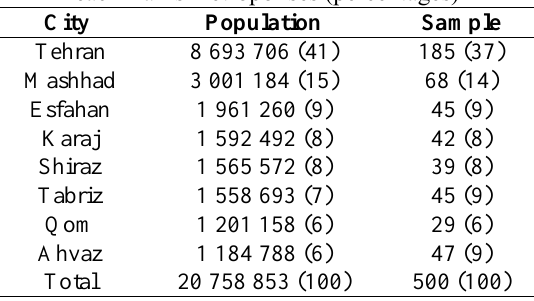
Table 1. Population and number of participants of each Iran’s metropolises (percentages) City